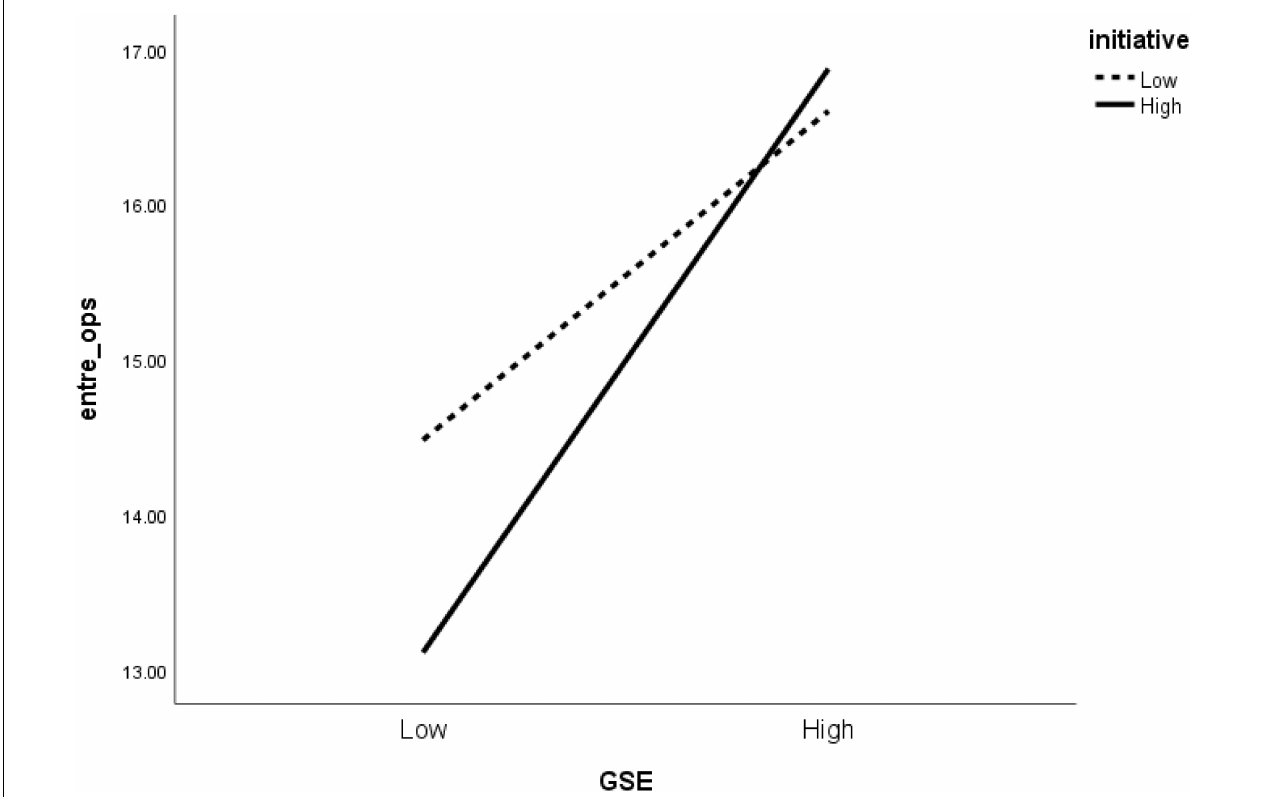
FIGURE 3 | Moderating effect of initiative on the relationship between GSE and entrepreneurial intention